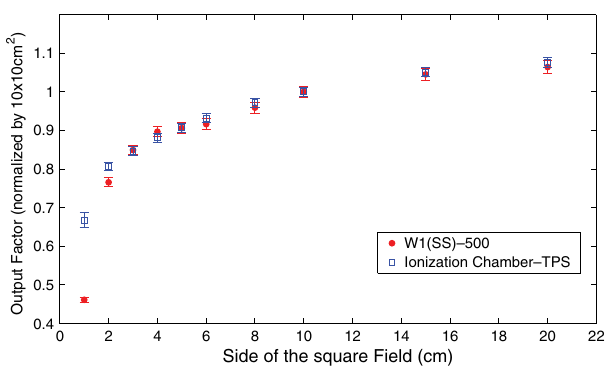
FIG. 11. Output factor measured with square fields in the cylindrical